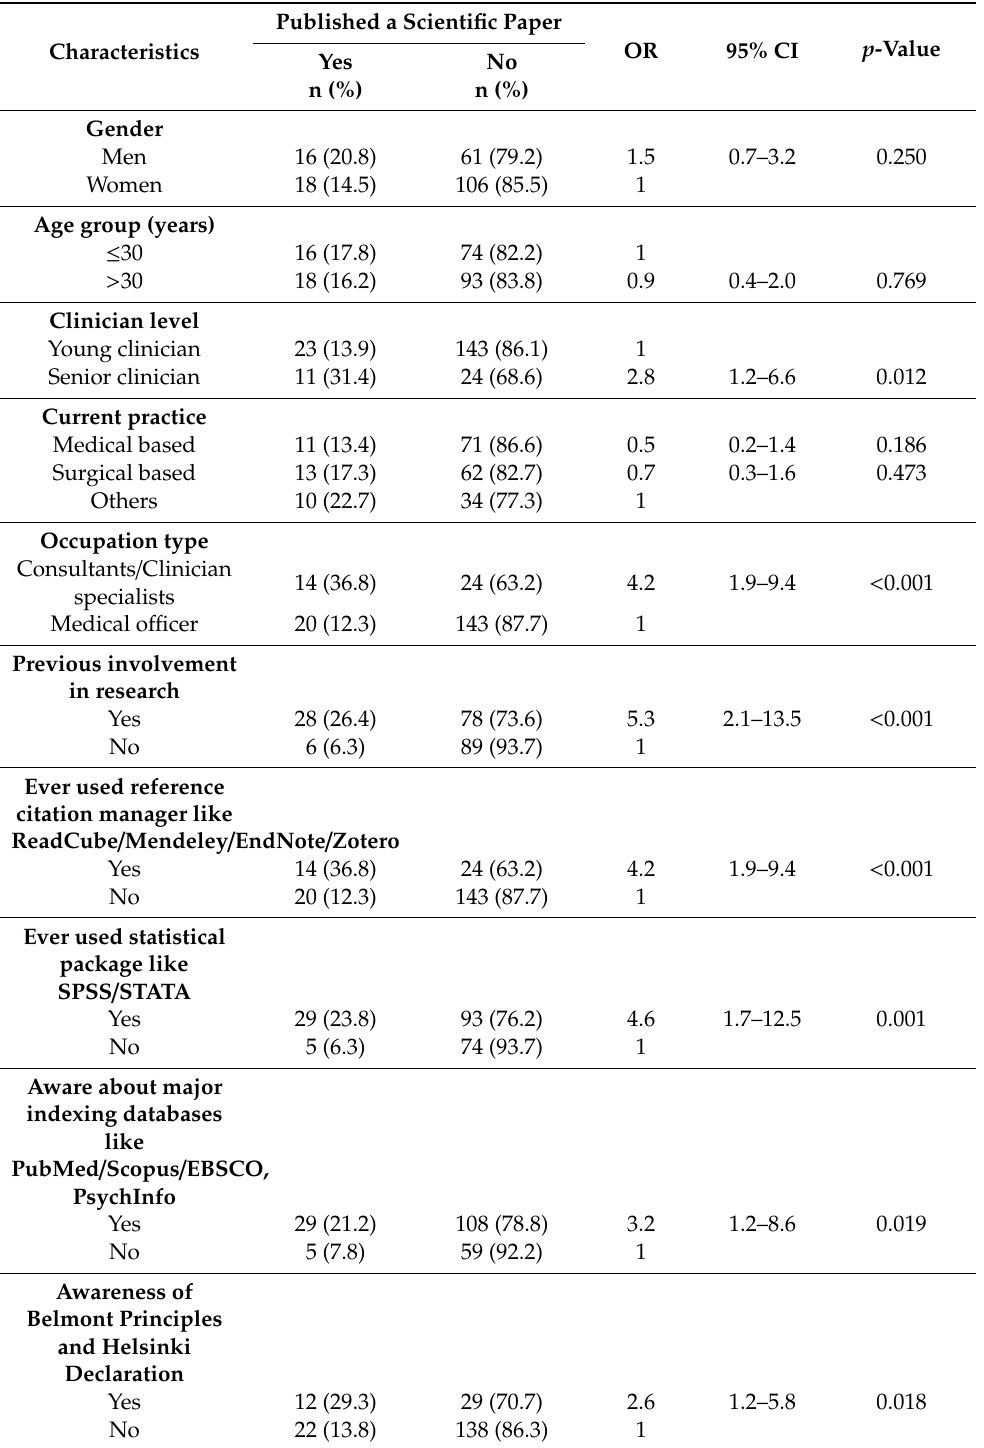
Table 4. Association between Socio-Demographic Characteristics, Researching Habits and Publication Output ( n = 201).